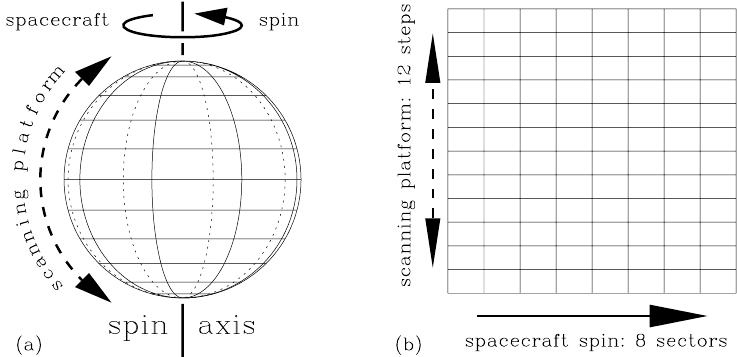
Fig. 1. (a) The measurement of particle fluxes over the unit sphere is produced during one 36.5s spin/scan cycle of the WAPS instrument onboard ISEE-1. (b) The unit sphere can be made into a mercator projection, on which pitch angle contours and flux intensities are overlaid. The resulting plot displays the Pitch Angle Distribution (PAD) used in subsequent figures (from Eccles and Fritz,